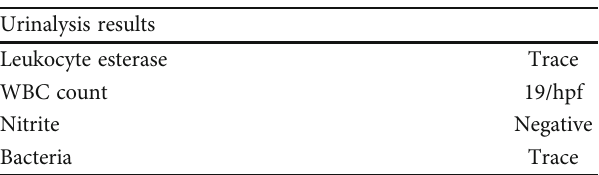
Table 3: Microscopic analysis of urine from initial sample at outside